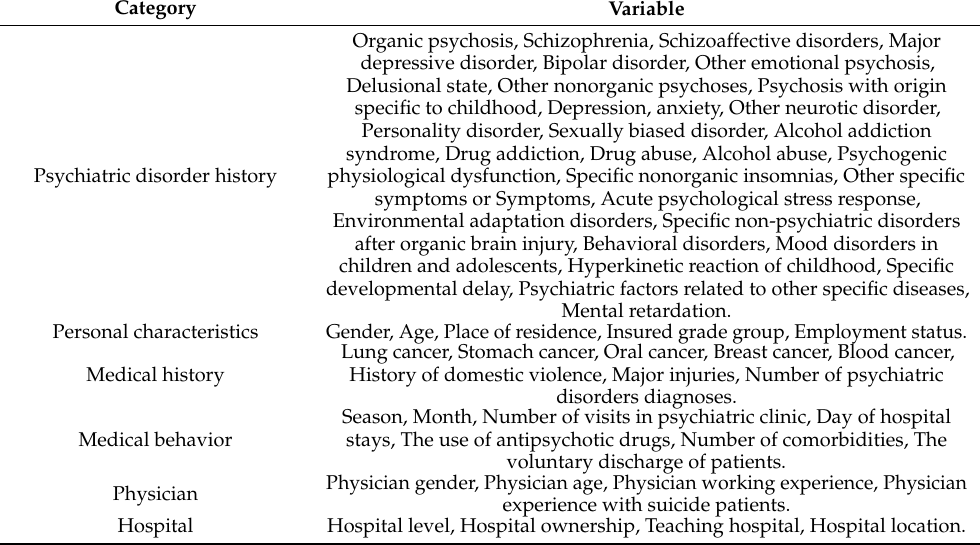
Table 1. Research